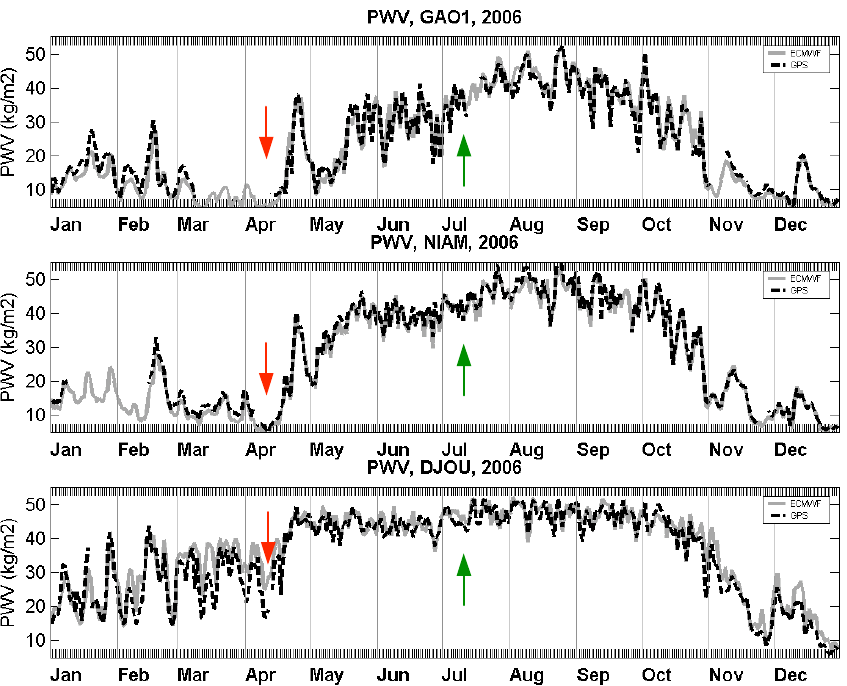
Fig. 10. Integrated atmospheric water vapour content estimated from GPS observations and analysed from ECMWF operational model at (top) Gao (16.3 ◦ N–0 ◦ E; Mali), (middle) Niamey (13.5 ◦ N–2.2 ◦ E, Niger) and (bottom) Djougou (9.7 ◦ N–1.7 ◦ E; Benin) in 2006 (see their location in Fig. 1). Red arrows indicate the onset of the first rainy season along the Guinean Coast and green arrows the onset of the summer rainy season over the Sahel.